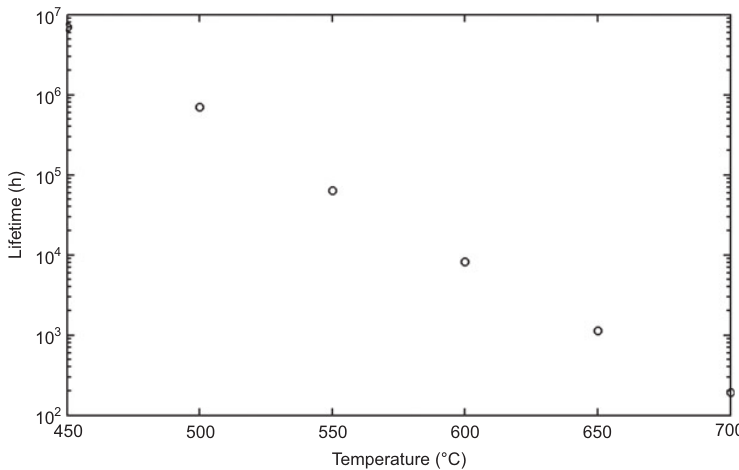
Figure 3 Evolution of the lifetime with the temperature (creep loading in dry atmosphere).